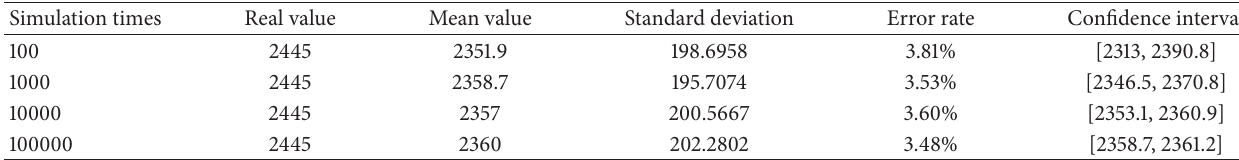
Table 1: Simulation results of SDE model.